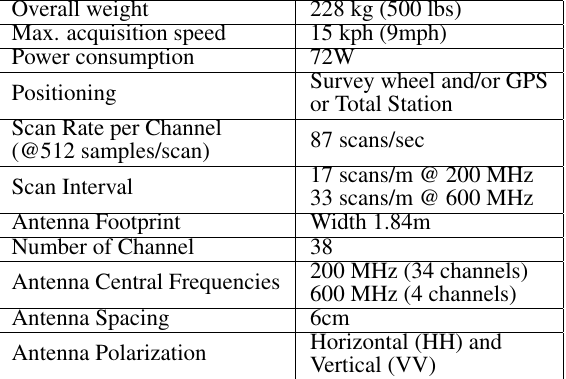
Table 1. Technical specifications of the Stream EM